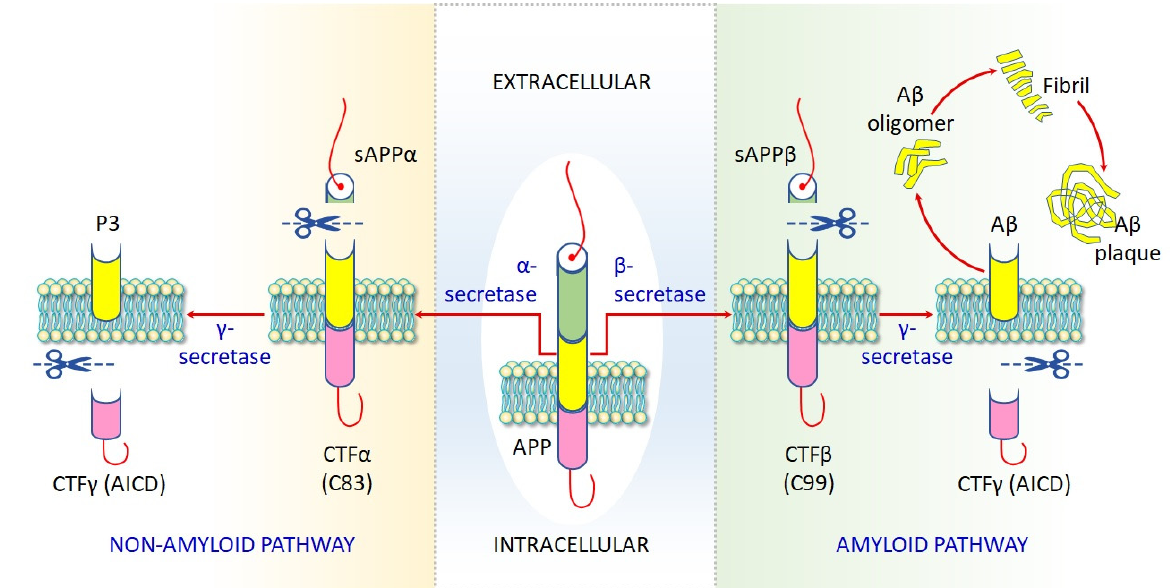
Figure 1. Mechanism of AD pathogenesis. The amyloid pathway is important to accumulate neurotoxic A β plaque via releases of β -secretase, which produces extracellular sAPP β and C99. Cleavage of the C99 fragment by γ -secretase releases A β oligomer, which subsequently produces A β peptide. By the action of α -secretase, two fragments of sAPP α and C83 are produced by the non-amyloid pathway. The non-amyloid pathway cleavages APP via α -secretase to produce two fragments: C83, an 83 amino acid intracellular C-terminal fragment, and extracellular sAPP α , soluble amyloid precursor protein α . Cleavage of the C83 fragment by γ -secretase yields a P3 peptide and CTF γ .